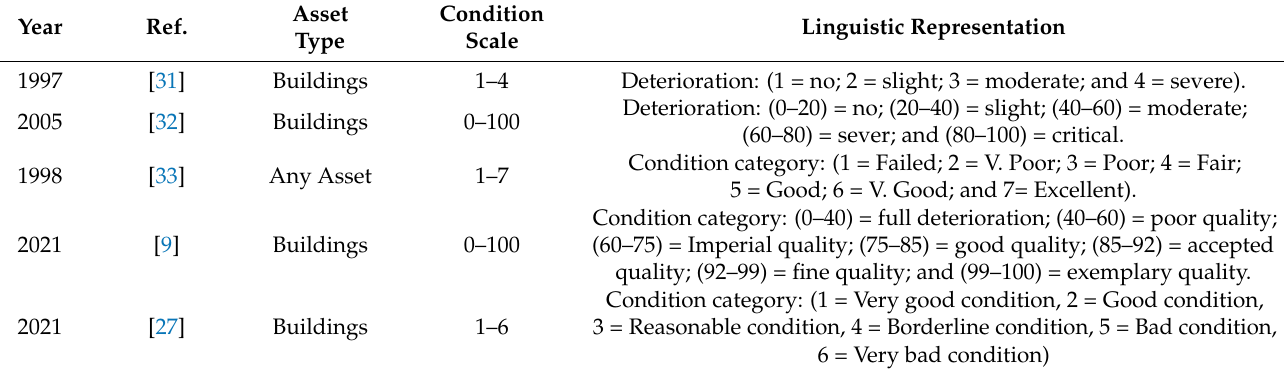
Table 1. Reference of different condition